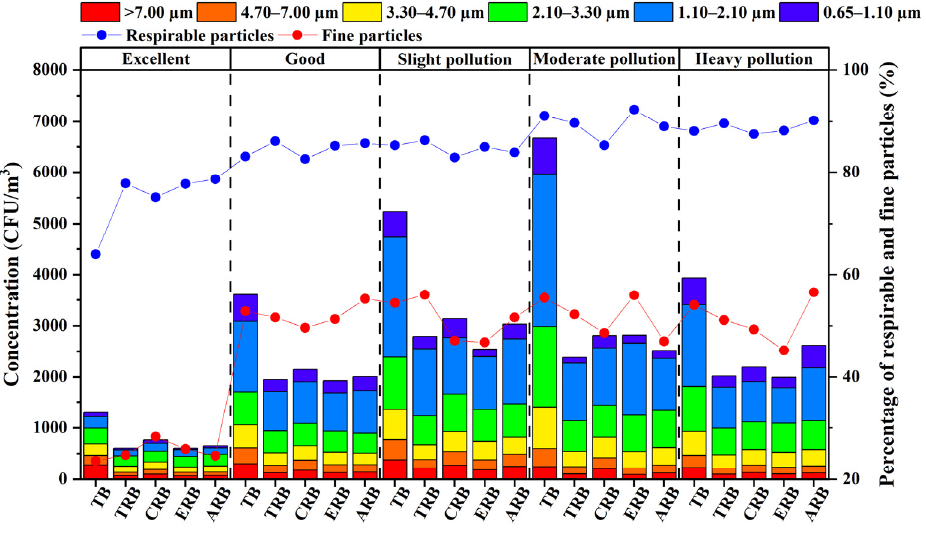
Figure 2. Size distribution of culturable bacteria and four antibiotic-resistant bacteria under different air quality levels.